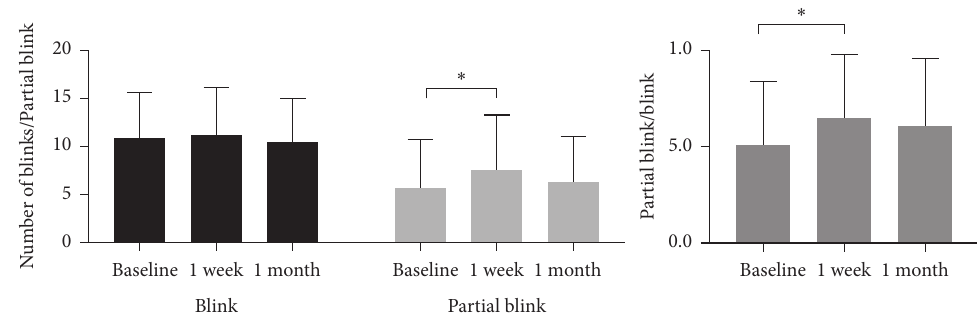
Figure 3: Blinks, partial blinks, and rate of partial blinks after orthokeratology lens wear. The number of blinks, the number of partial blinks, and rate of partial blinks of the 56 patients at baseline, 1 week, and 1 month after orthokeratology treatment. ∗ denotes p < 0 . 05.